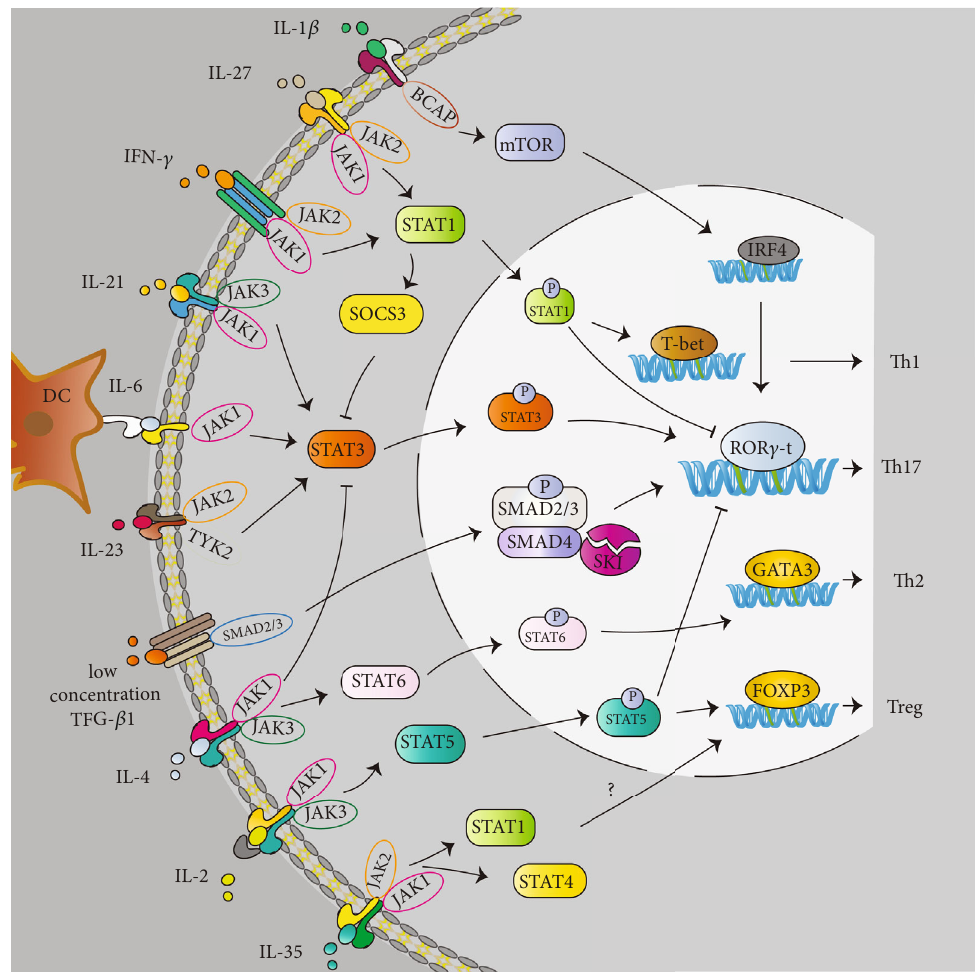
Figure 3: The main pathways of IL-6, TGF- β 1, IL-1 β , IL-23, IL-27, IL-35, IL-2, IL-4, IL-21, and IFN- γ signaling to induce the di ff erentiation of Th17